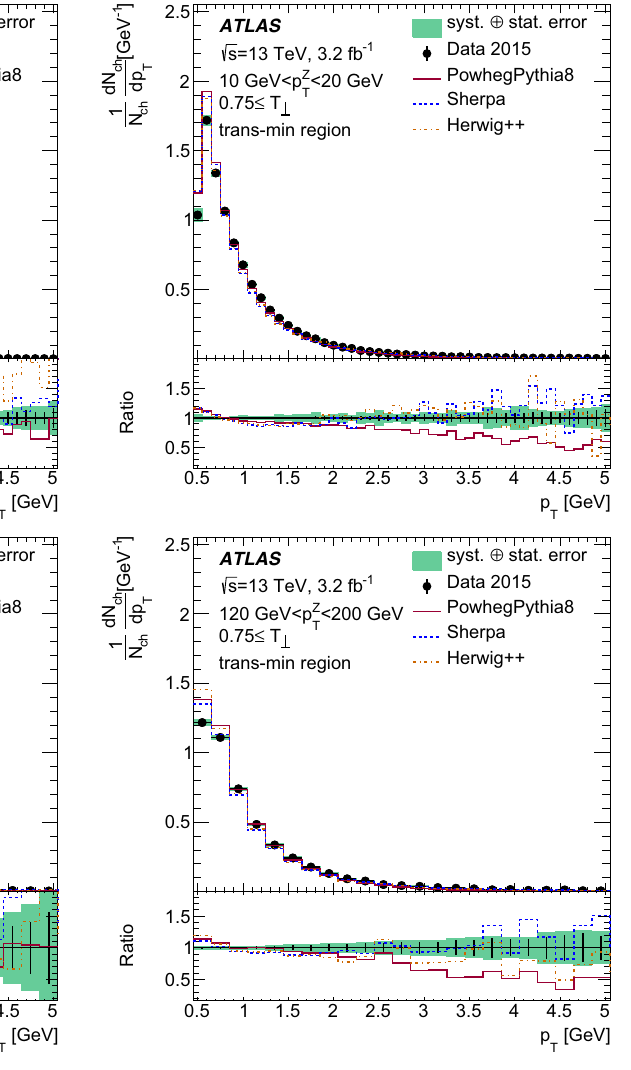
Powheg + Pythia , Sherpa , and Herwig++ are compared with the Fig. 6 Measured p T spectra in the trans-min region for T ⊥ < 0 . 75 < 20 GeV (left) and 0 . 75 ≤ T ⊥ (right) for events with 10 < p Z T < 200 GeV (lower row). Predictions of (upper row) and 120 < p Z T